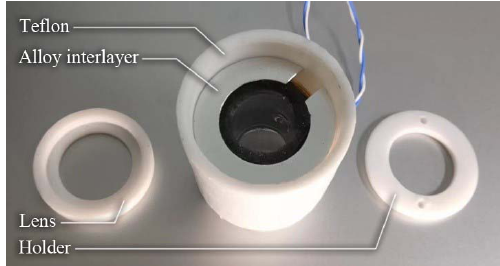
Figure 14. The structure of the atomic cell heater.